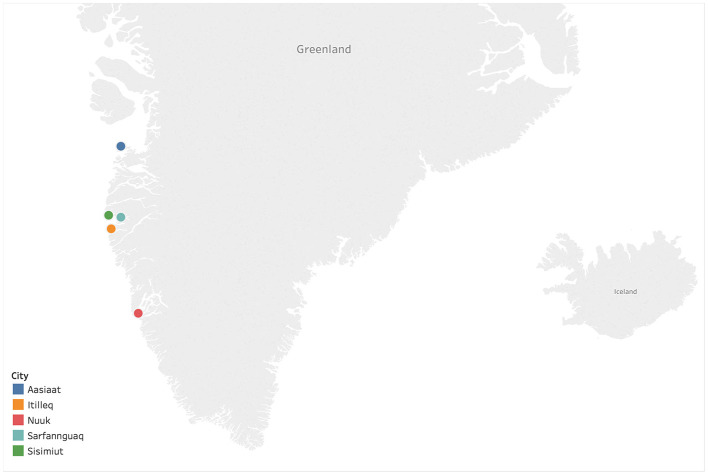
Sampling locations of Hepatitis B virus (HBV) isolates within Western Greenland. The map was generated using Tableau Desktop 2009.1 (https://www.tableau.com).